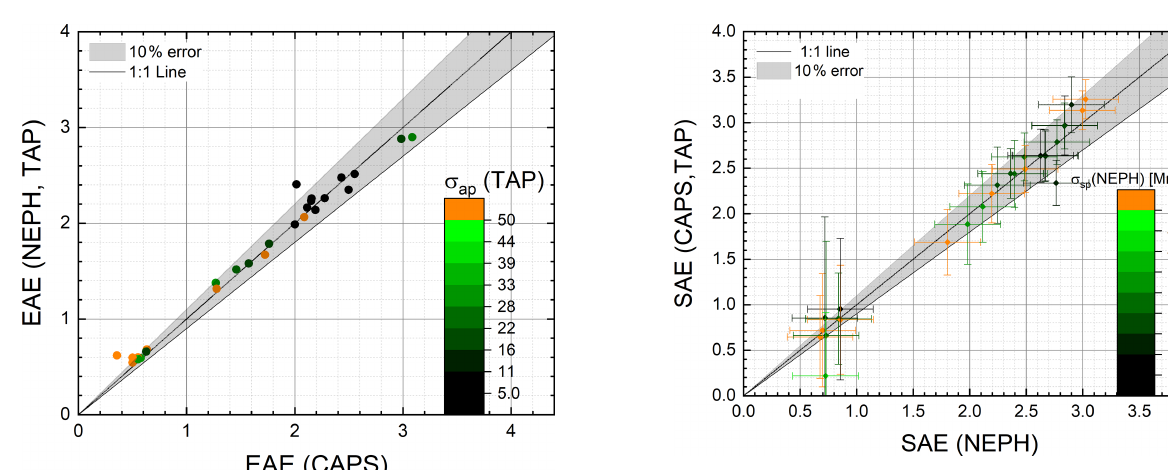
Figure 9. Scatter plot of EAE(NEPH, TAP) measurements com- pared to EAE(CAPS) measurements for AQ–AS mixtures. An error band of 10% is shown.